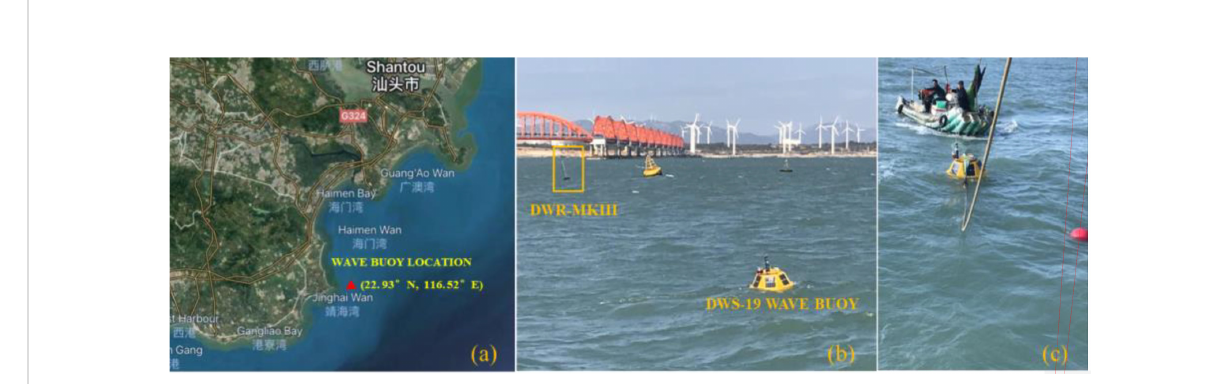
FIGURE 10 Filed comparison with DWR-MKIII wave buoy: (A) Filed comparison location. (B) Offshore comparison site. (C) Deployment of DWS19 Wave Buoy.